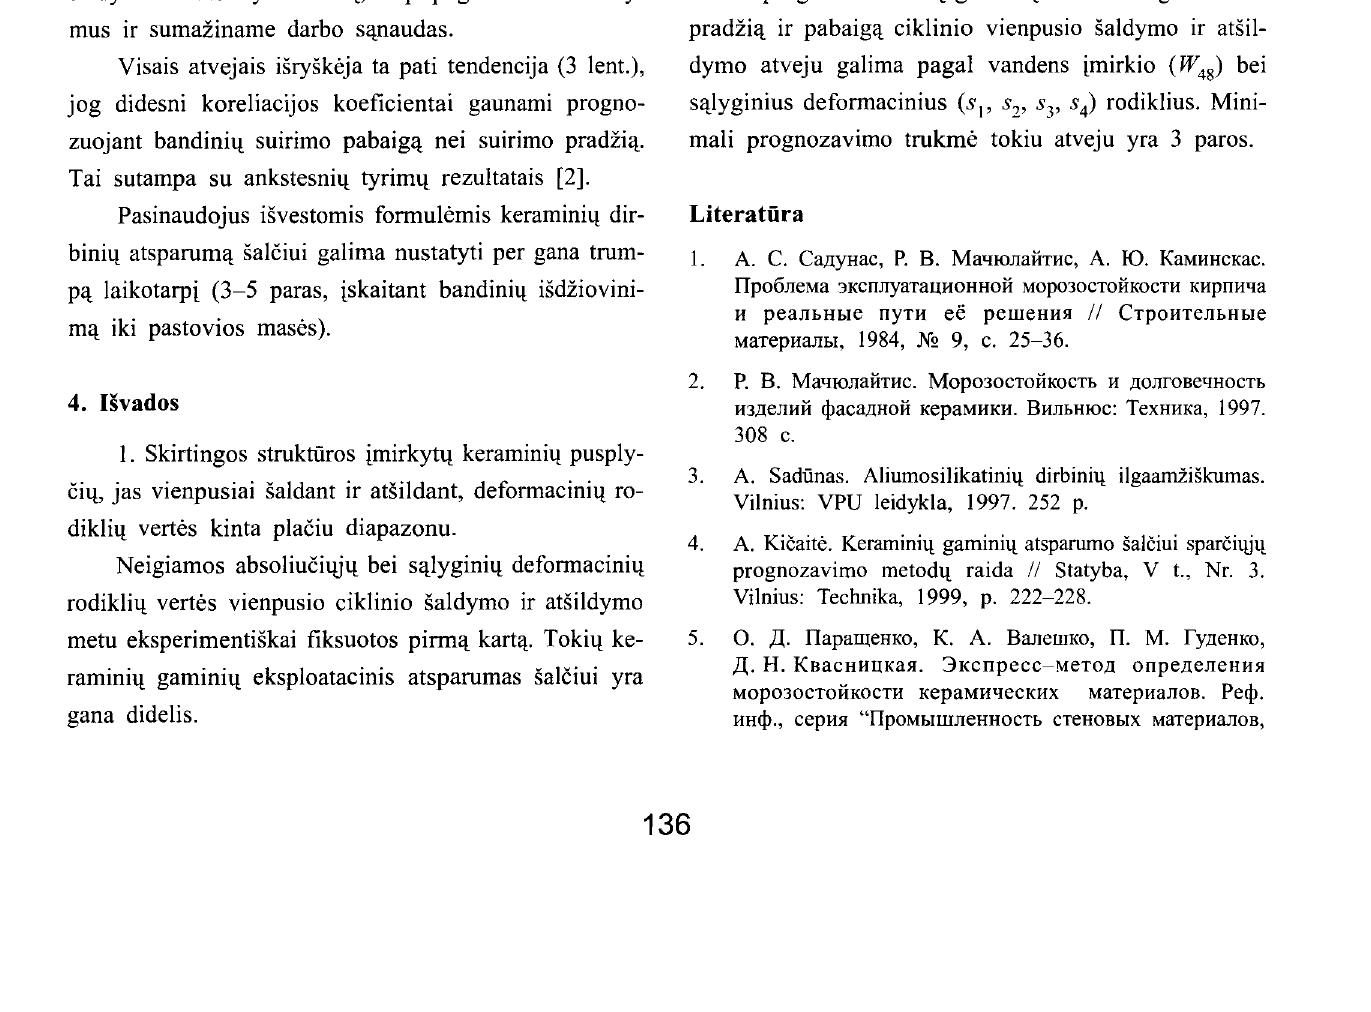
Empirine lygtis koeficientas R, dispersija,